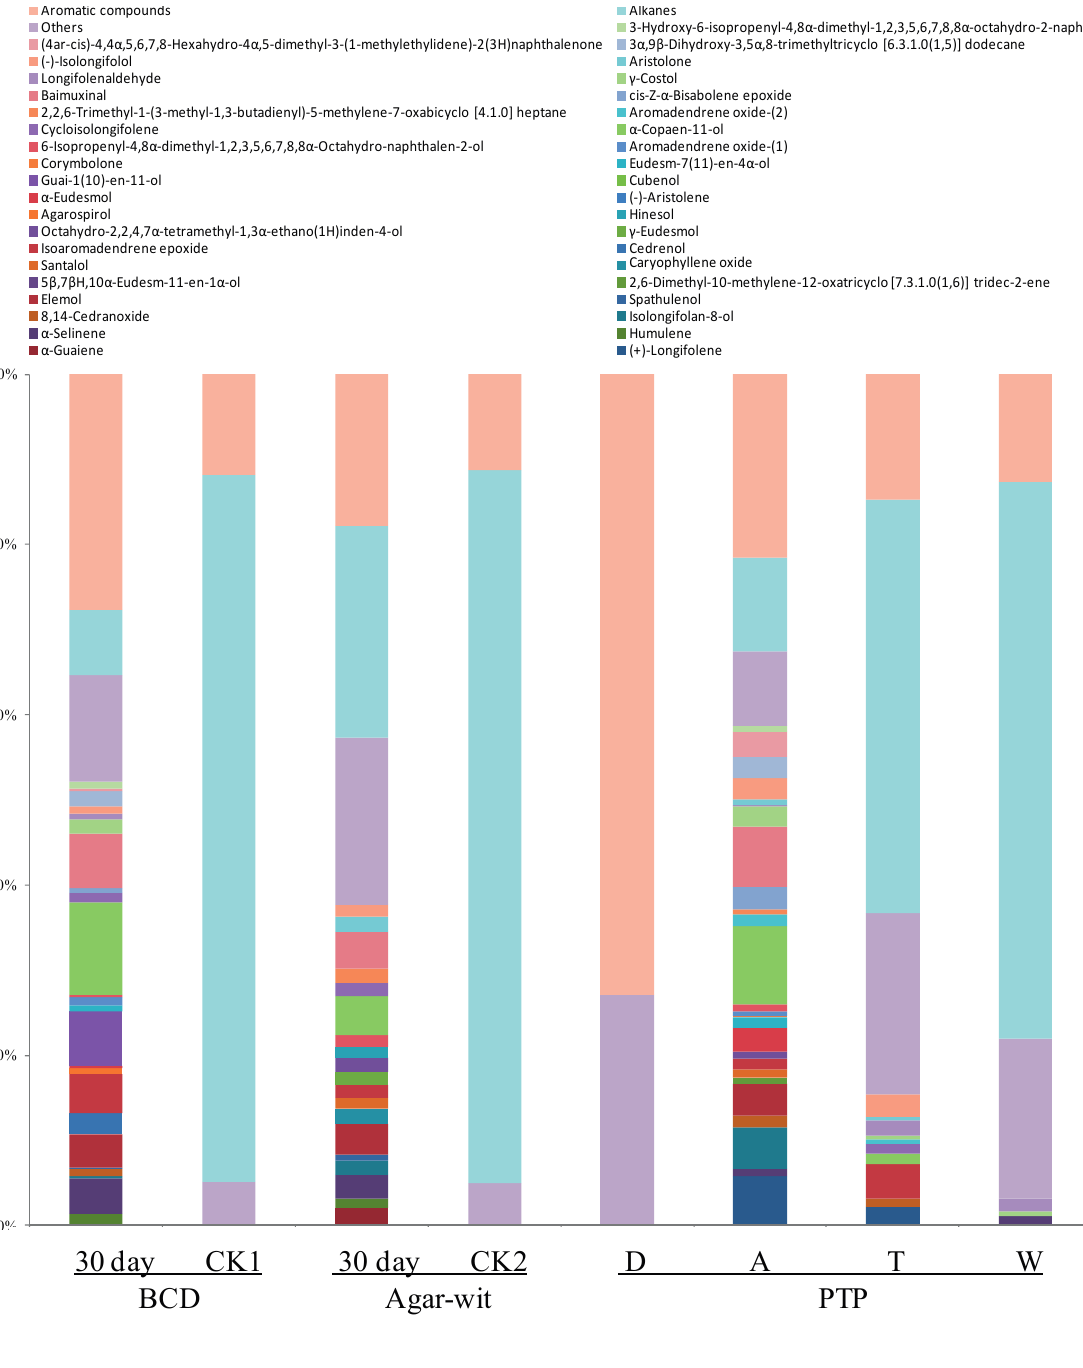
Figure 3. Type and content of essential oils in the agarwood samples obtained by the three different wounding methods, BCD, Agar-Wit and PTP. The wounded wood obtained by the partial-trunk-pruning (PTP) method was divided into four zones, the decay (D), agarwood (A), transition (T), and white (W) zones. The samples obtained from the untreated healthy trees and the trees treated by the Agar-wit with ddH 2 O not inducers are referred to as CK1 and CK2, respectively. Relative amount (%) was defined to be the peak area relative to the total peak